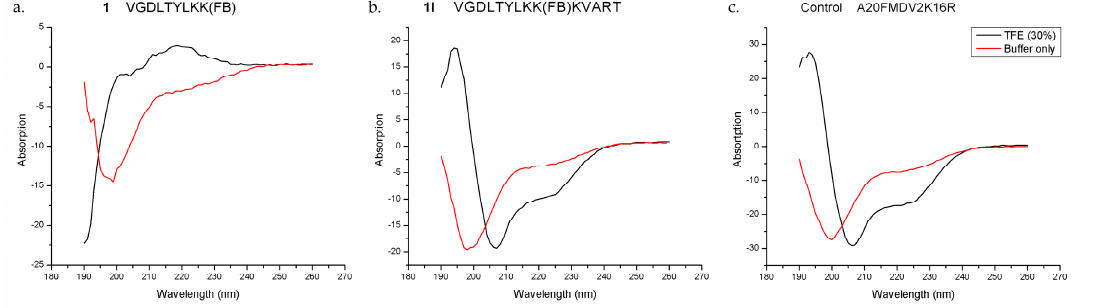
Figure 5. Circular dichroism (CD) spectra of ( a ) the parent peptide 1 , ( b ) 1i , and ( c ) the control peptide in aqueous buffer (red) and in 30% TFE (black).